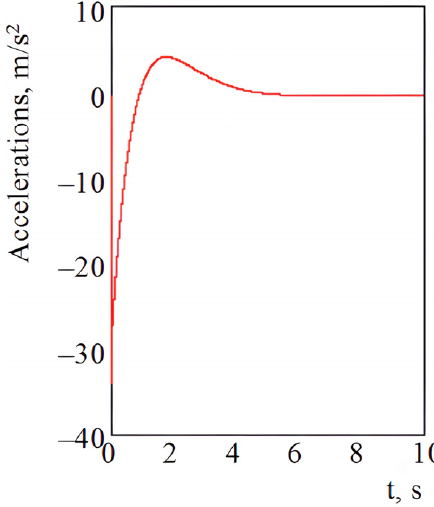
Figure 9. Accelerations on the removable module. Table 1. Basic technical characteristics of Steel 09C2Cu.